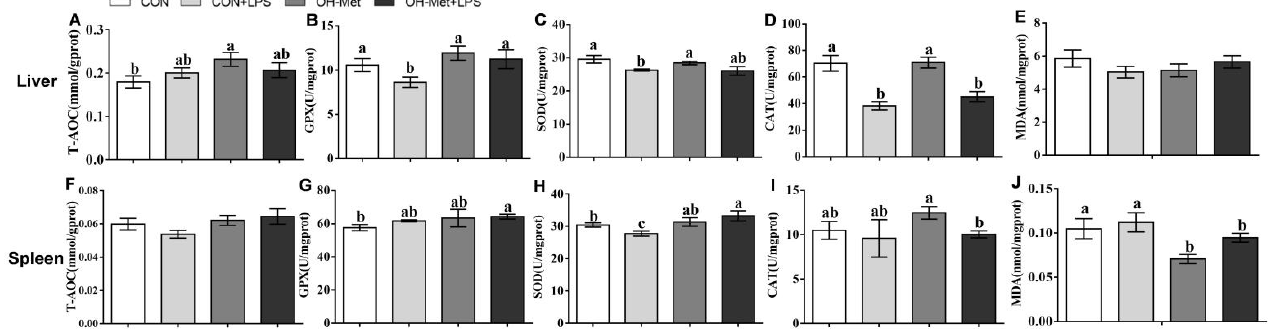
Figure 2. The effects of OH-Met supplementation on antioxidant indexes of the ( A – E ) liver and ( F – J ) spleen after 24 h LPS challenge in weaned piglets. The values are the means ± SEs, n = 5. Labeled means in a row without a common letter differ, p < 0.05. T-AOC, total antioxidant capacity; GPX, glutathione peroxidase; SOD, superoxide dismutase; CAT, catalase; MDA, malondialdehyde; CON, piglets receiving a control diet and injected with saline; CON+LPS, piglets receiving the control diet and challenged with LPS; OH-Met, piglets receiving a diet that was supplemented OH-Met at 25% above the total SAA present in the CON diet and injected with saline; OH-Met+LPS, piglets receiving a diet that was supplemented OH-Met at 25% above the total SAA present in the CON diet and challenged with LPS.